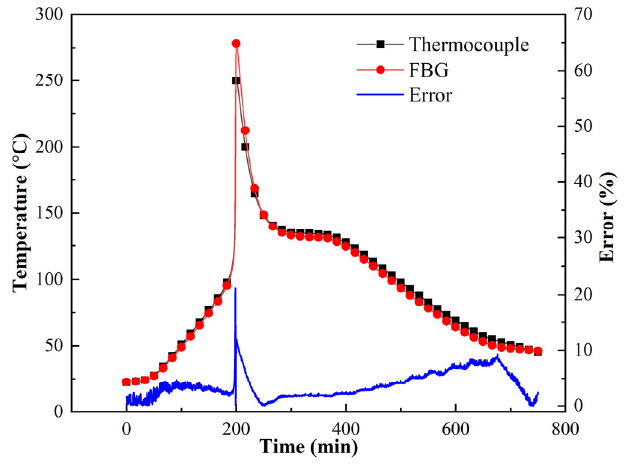
Figure 11. Comparison of temperatures monitored by FBG and thermocouple.